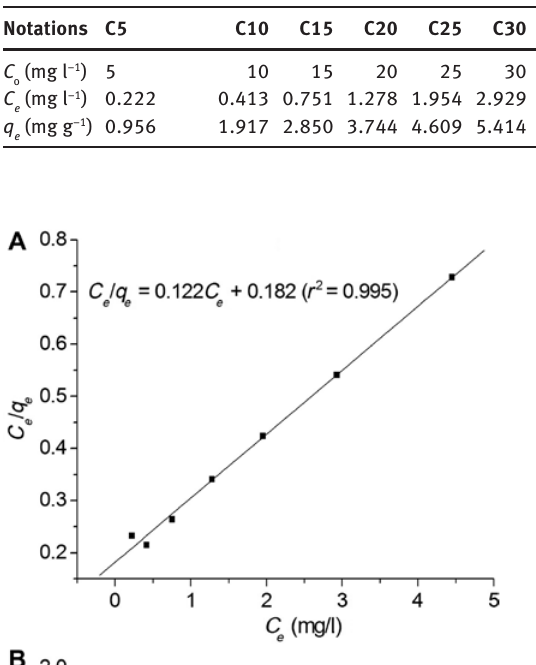
Figure 6: FT-IR spectra of RHA (A) and RHA/Al(OH)